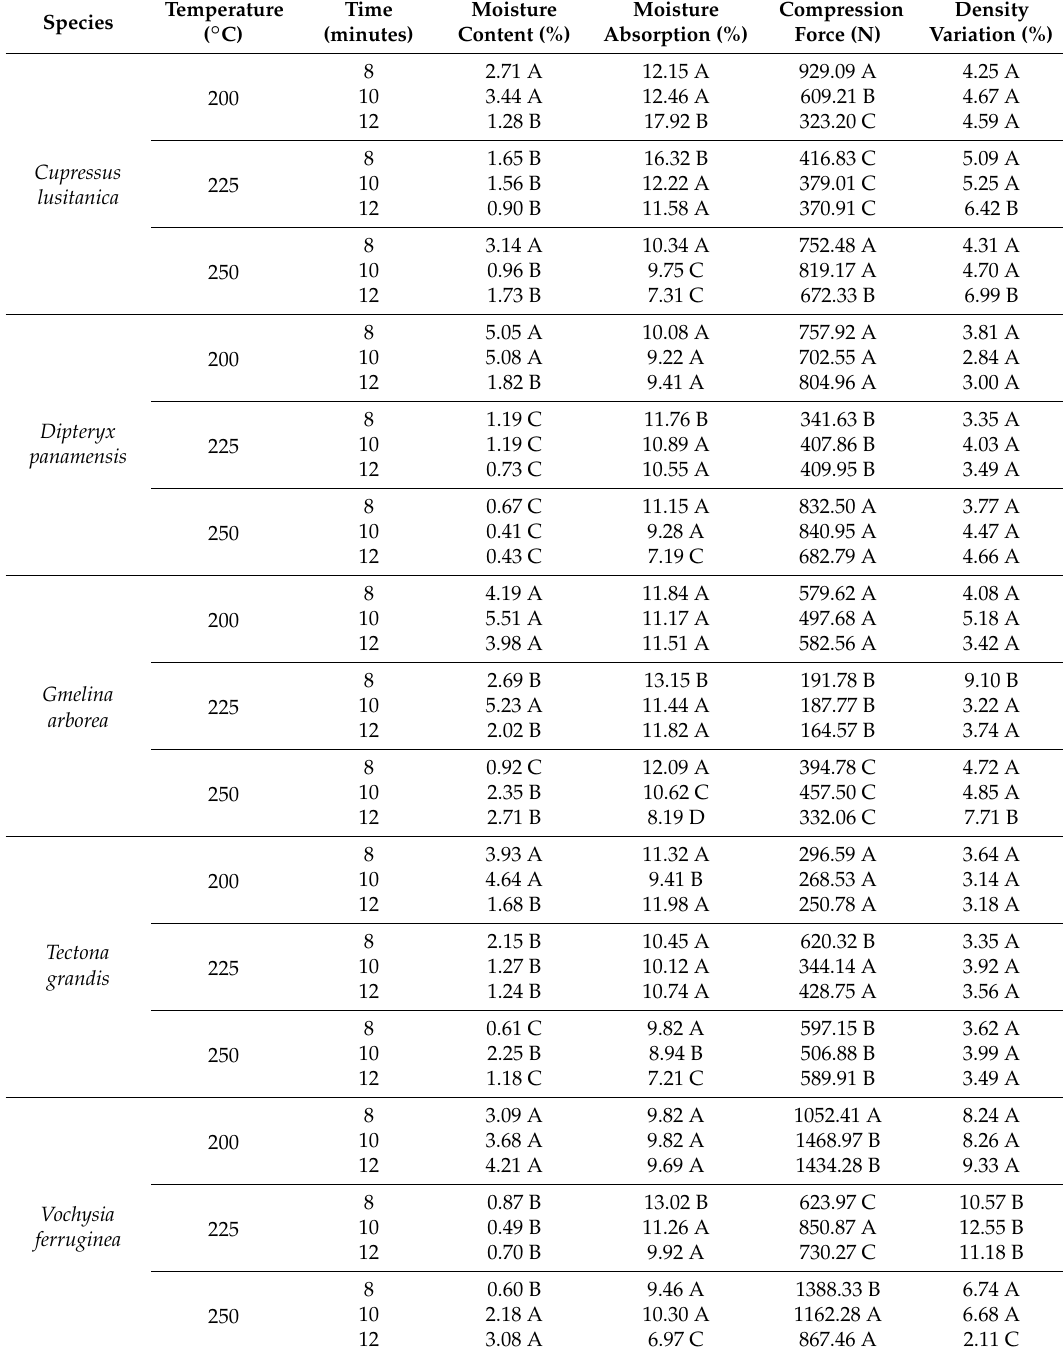
Table 1. Moisture content, moisture absorption, and compression force of pellets torrefied at different temperatures and times for five types of biomass from woody tropical